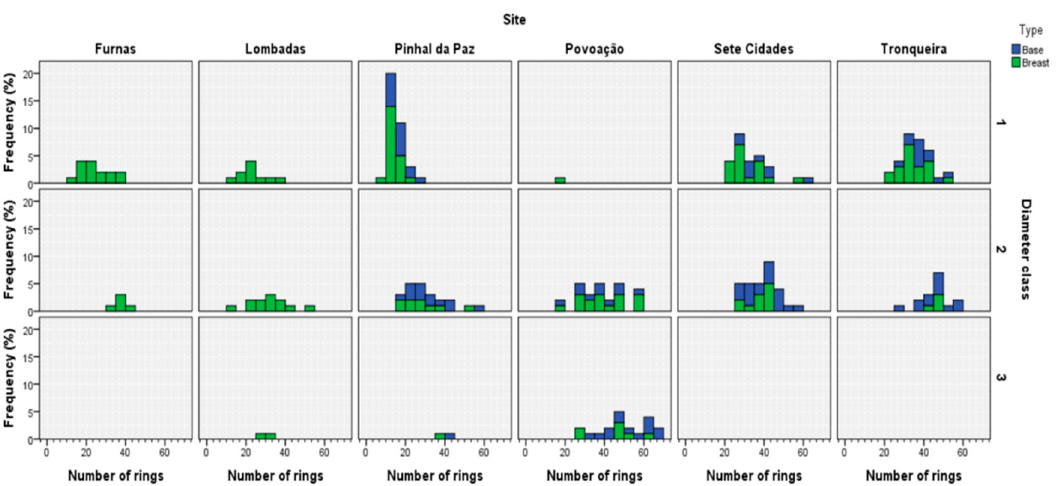
Figure 7. Distribution of the cambial age of L. azorica (Seub.) Franco trees obtained at six sites in São Miguel Island. The chart allows to appreciate the age and size structure of the different populations. Diameter classes (cm): (1, < 10; 2, 10–20; 3, > 20 cm).